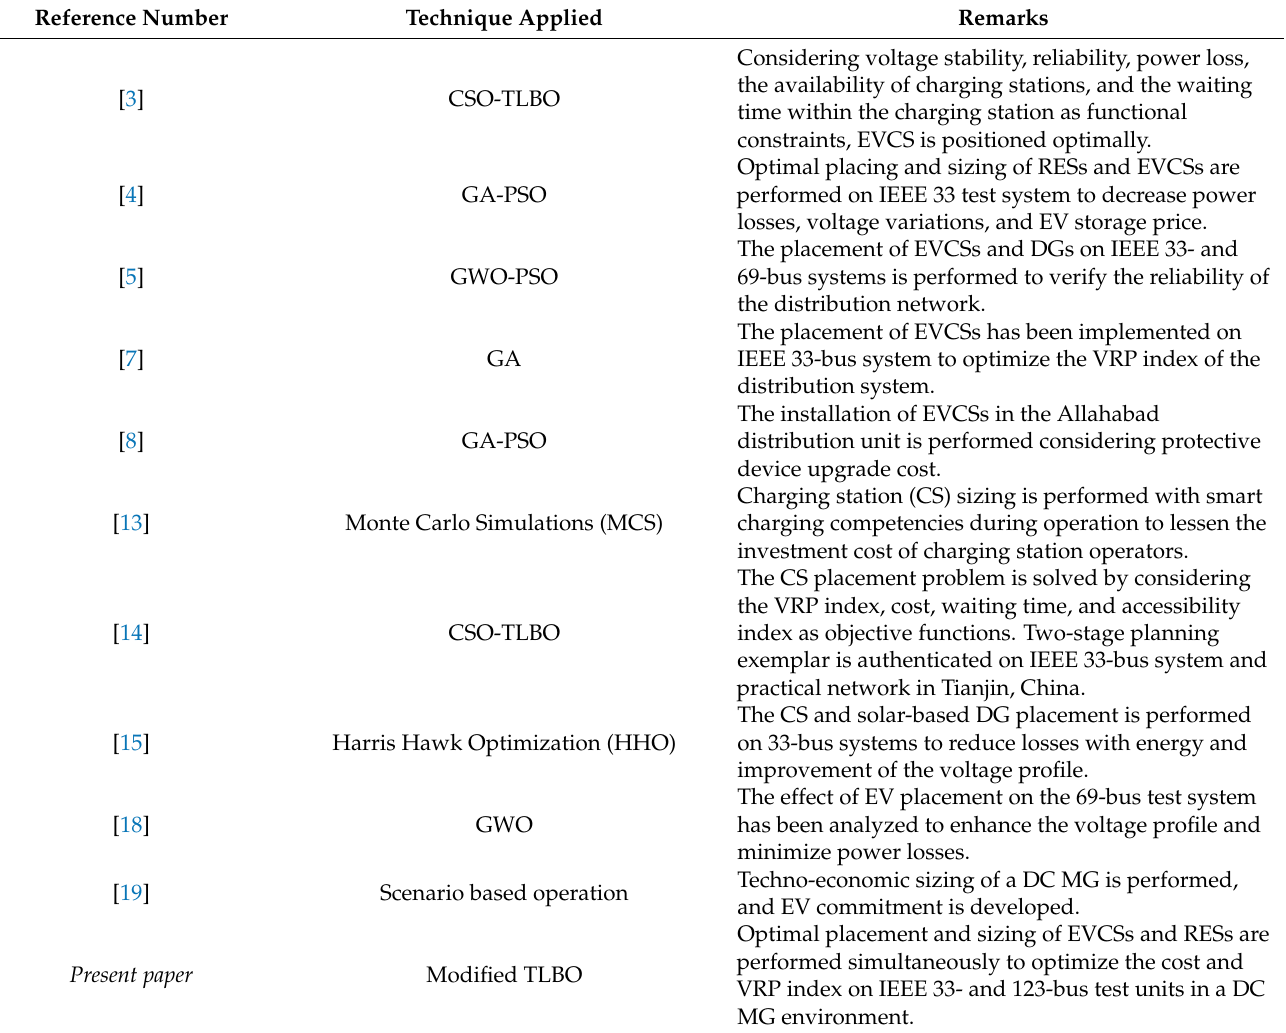
Table 1. Comparison of literature